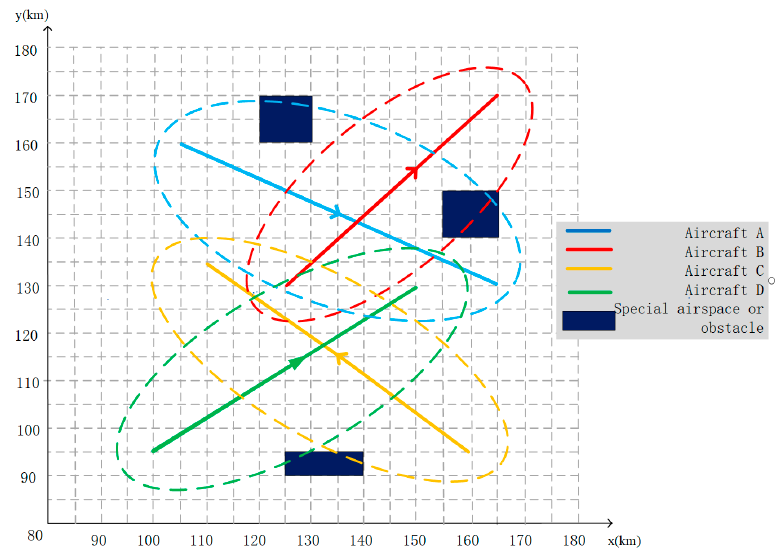
Figure 11. Schematic of the potential motion space of the four aircrafts.